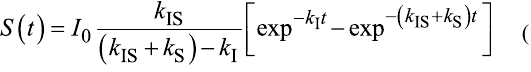
lock field generated by the spectrometer acquisition